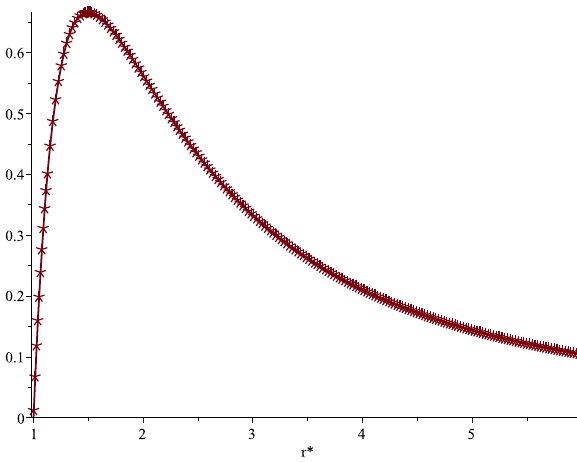
Fig. 6 Plot of the effective potentials (28) (long-dash line) (Schwarzschild case) and (30) (solid line) in the massless case when L = 3, H = 10 and ξ = 0 . 2. This choice of H gives rise to a scal- ing factor h of the same order as h E = 2 . 121 × 10 − 9 kpc in [29,30] and central object is modelled in terms of a droplet (see also Fig. 6). The maximum of V ef f , S is located at the radius of the photon sphere r ∗ γ = 3 / 2 while the event horizon of the Schwarzschild black hole is r ∗ s = 1. Note that the effective potential given by (30) does not exhibit a maximum and therefore, the droplet does not possess a photon sphere